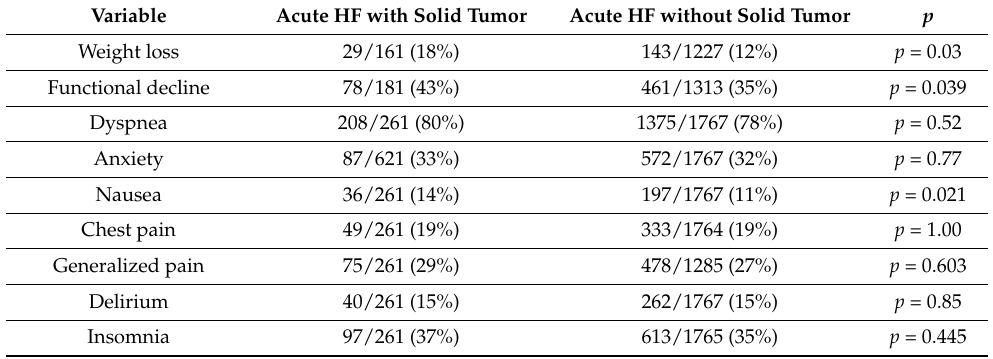
Table 2. Clinical characteristics of patients with and without cancer in patients with acute heart